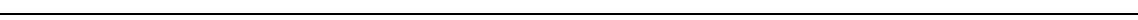
Fig. 1 Overexpression of PGC-1 α in skeletal muscles suppresses fi brogenesis in Folic Acid Nephropathy (FAN). a PAS staining of kidney sections from wild type (Wt), muscle-speci fi c PGC-1 α overexpression (mPGC-1 α ) with or without folic acid-induce nephropathy (FAN) are shown, representative image derived from 7 animals of each group. At 2 weeks after FAN, there were less tubule dilation, atrophy and brush-board loss in mPGC-1 α mice vs. Wt mice